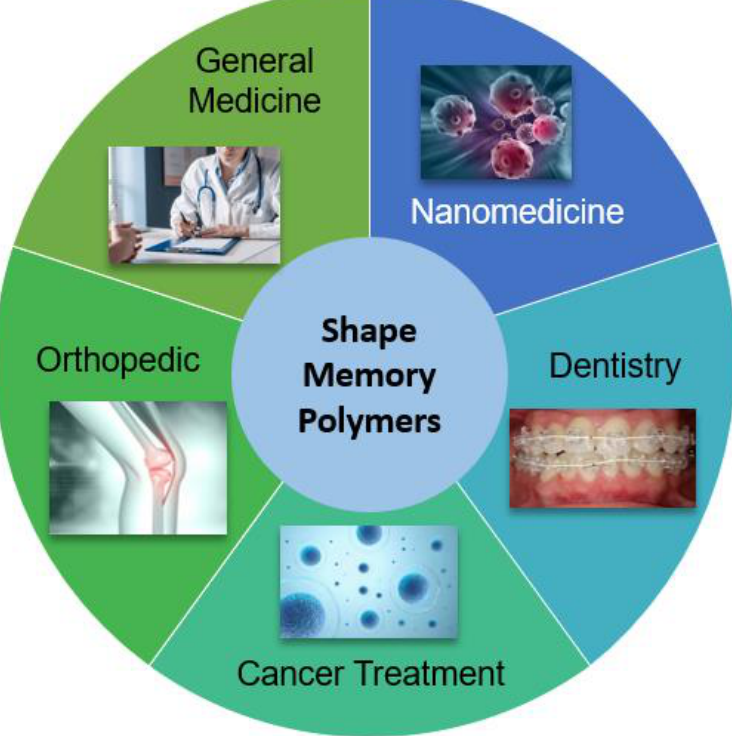
Figure 3. Biomedical applications of shape memory polymers (SMPs).